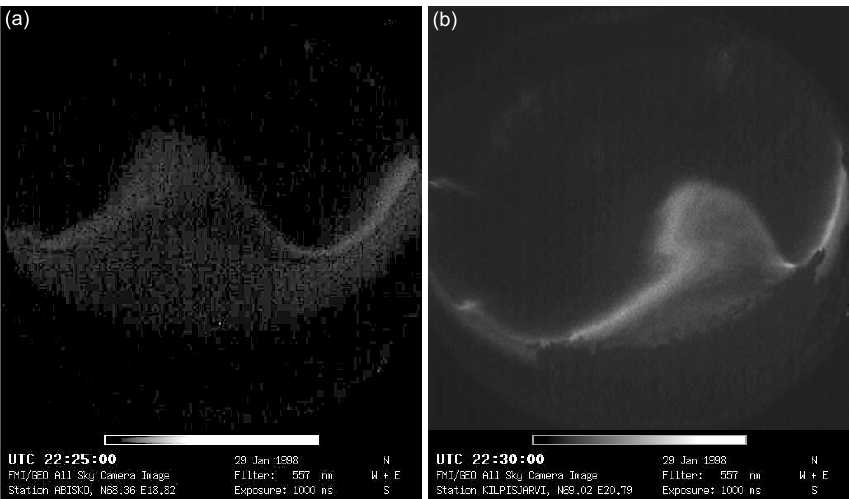
Figure 8. Auroral omega forms observed at ABK at 22:25UT (a) and KIL at 22:30UT (b) . The contrast in the images has been